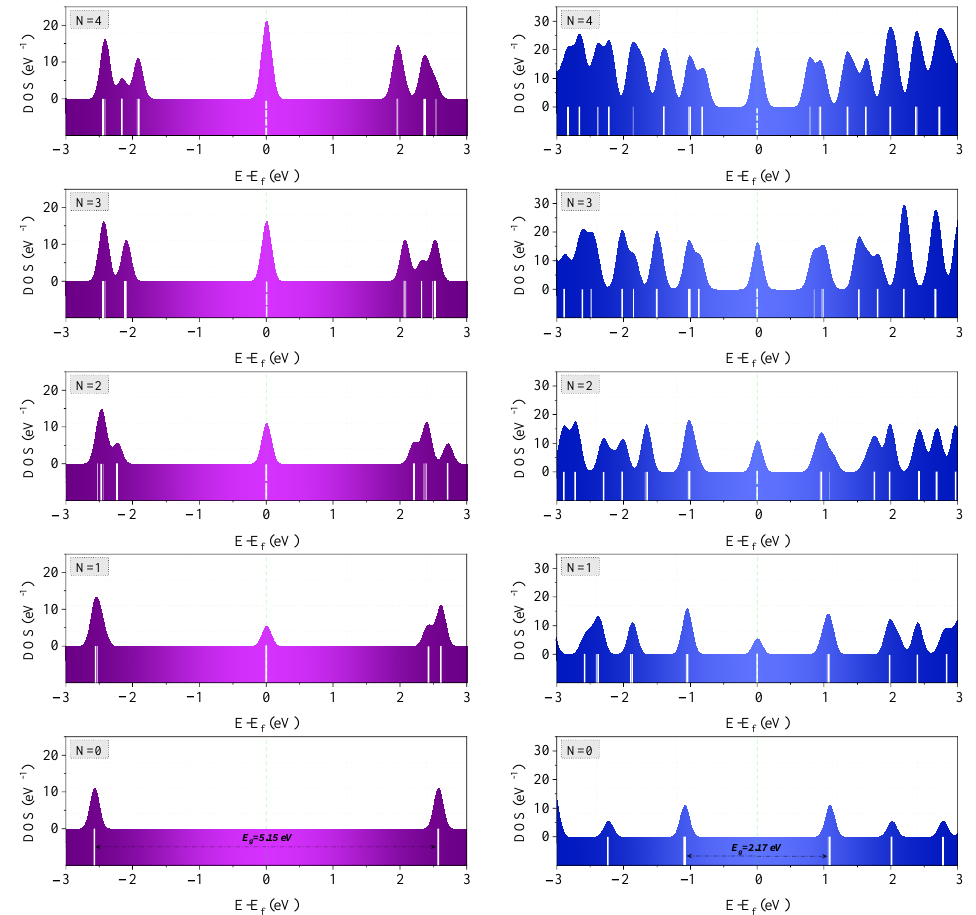
Figure 9. Total density of states (TDOS) and energy spectrum of the ( left ) graphene, and ( right ) sil- icene zigzag trigonal nanodiscs for different widths from N = 0 to N = 4. The dashed lines on colored bars indicate the degeneracy of energy